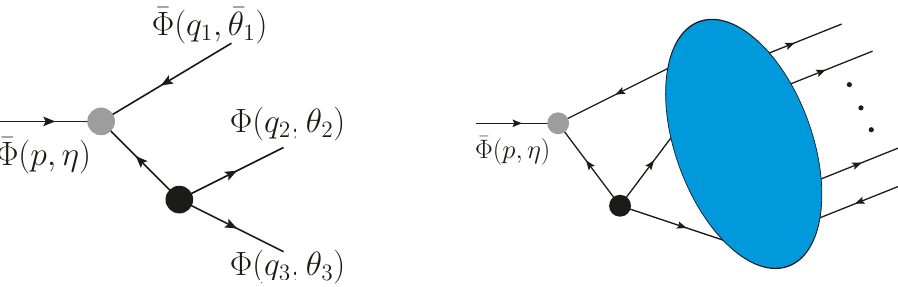
Figure 4 . Left: tree level supergraph formed by chiral and antichiral vertices with one on-shell and three o(cid:11)-shell legs (3.30). Right: as a subdiagram of a bigger multi-loop supergraph it does not produce a new collinear S -anomaly with p